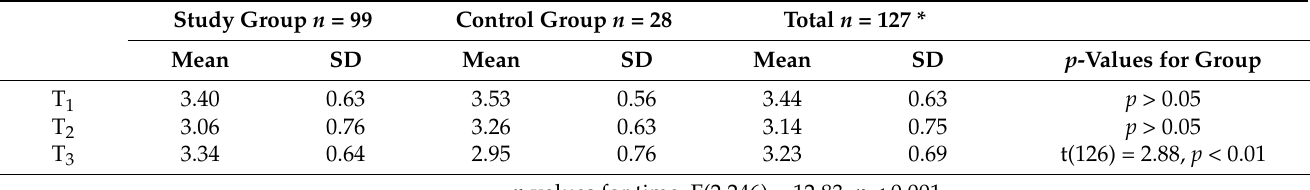
Table 2. Mean scores and standard deviations of childbirth self-efficacy at T 1 –T 3 (weighted for age). Study Group n =